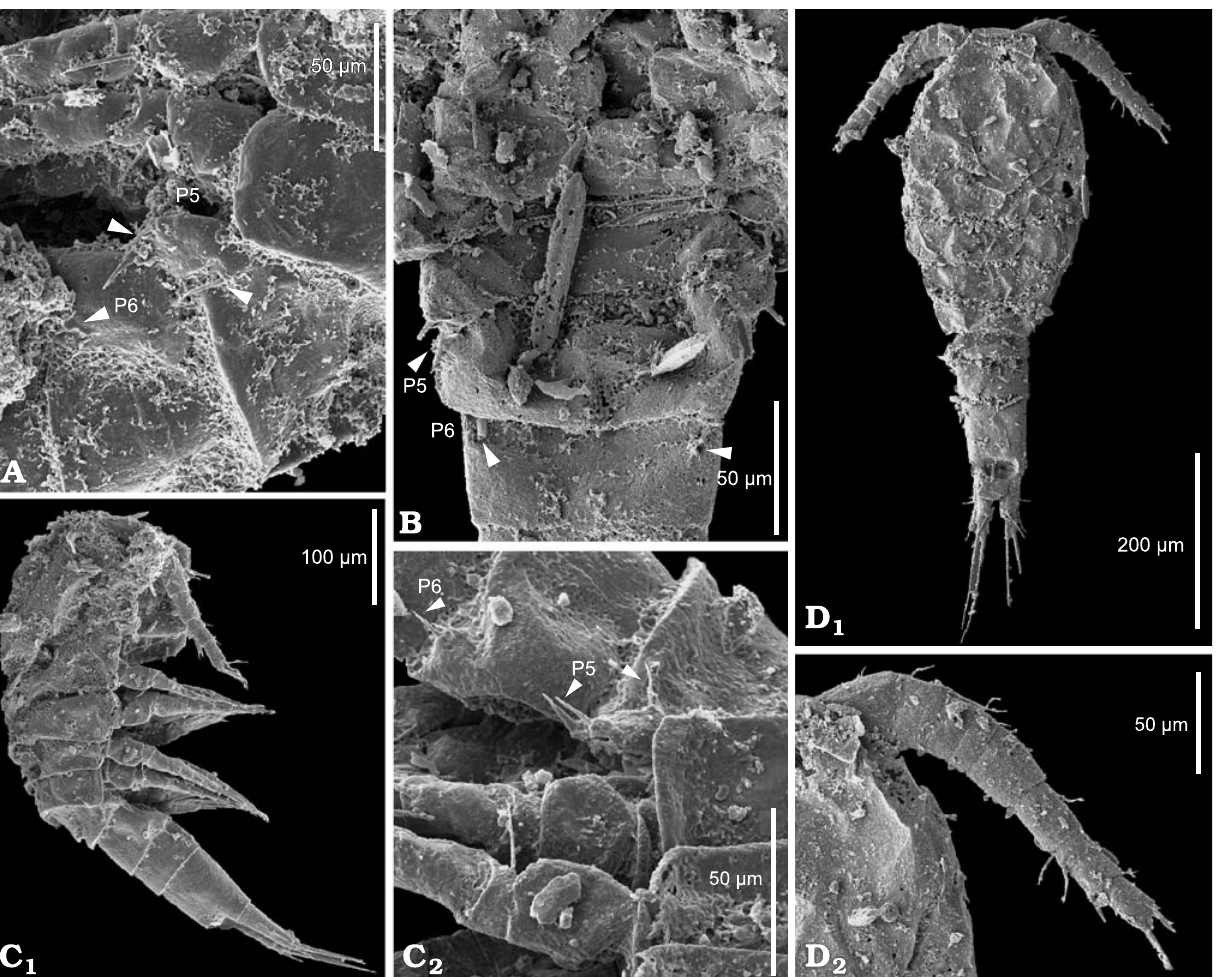
Fig. 8. Cyclopid copepod Apocyclops californicus sp. nov. from Mud Hills, Southern California; Burdigalian–Langhian, Miocene. A , B . Copepodid V. A . UMNH IP 4857, female, swimming legs 3 − 4, leg 5 and leg 6, in lateral view; arrowheads point to lobe setae and lateral seta of leg 5, and posteriormost seta of leg 6. B . UMNH IP 4825, male, leg 4 protopodite in caudal view, urosomites 1 − 3 in ventral view; arrowheads point to setae of leg 5 and leg 6. C . Copepodid IV, UMNH IP 4835, habitus in lateral view (C 1 ), coxopodite, basipodite, and first exopodal segment of leg 3 and 4, leg 5, and leg 6 (C 2 ). D . Copepodid III, UMNH IP 4849, habitus (D 1 ) and nine-segmented antennule (D 2 ) in dorsal